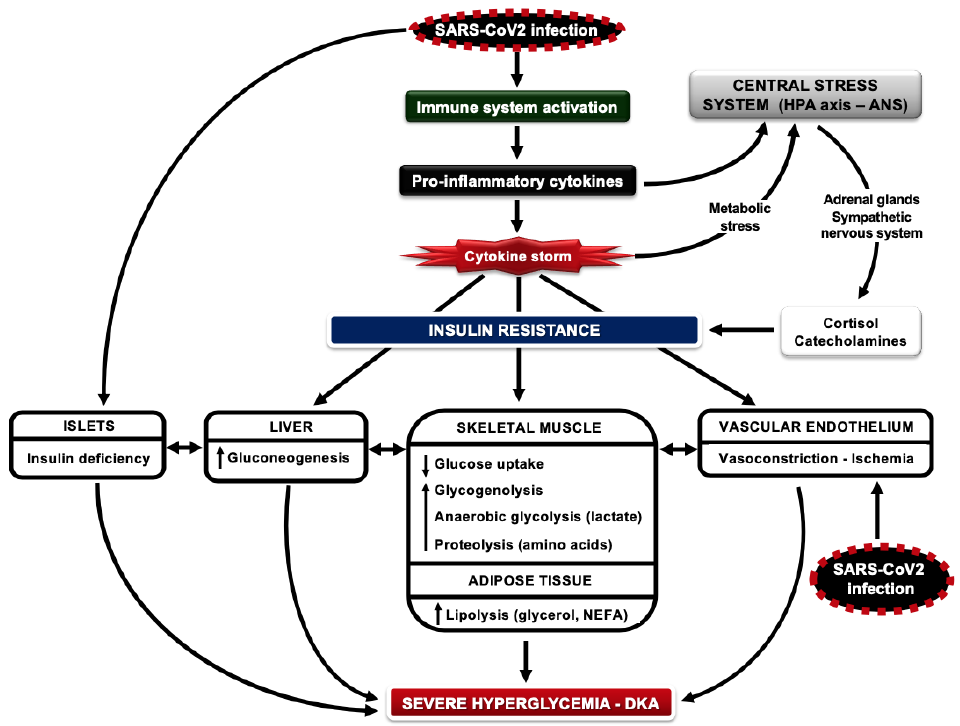
Figure 1. Severe acute respiratory distress syndrome coronavirus 2 (SARS-CoV2) infection activates the immune system, resulting in the secretion of pro-inflammatory cytokines, which mediate: (a) insulin resistance in insulin-sensitive tissues such as the liver, skeletal muscle, adipose tissue and vascular endothelium by inhibiting insulin signal transduction and (b) increased activation of the secretion of cortisol, epinephrine and norepinephrine, which in turn aggravates and sustains insulin